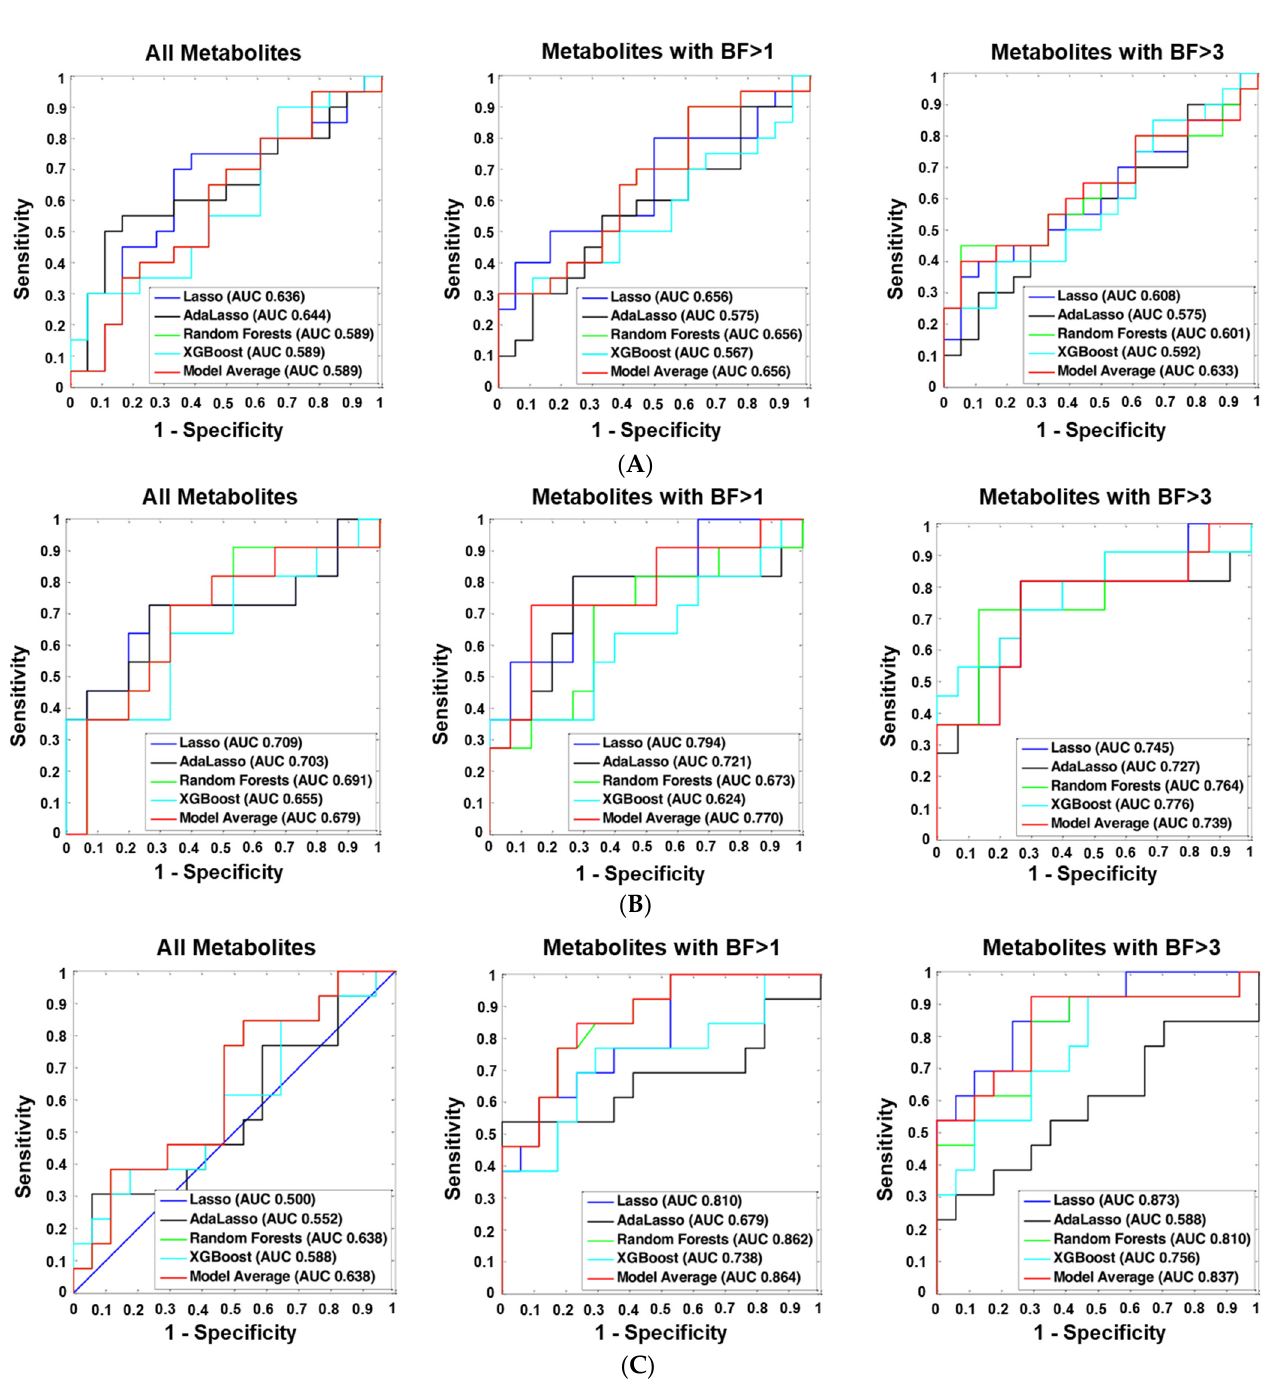
Figure 3. ME/CFS predictive modeling. ME/CFS: myalgic encephalomyelitis/chronic fatigue syndrome; sr-IBS: self-reported physician diagnosed irritable bowel syndrome; BF: BayesFactor; AUC: area under the receiver operating characteristic curve. To differentiate ME/CFS cases from healthy controls, we employed five machine learning algorithms: least absolute shrinkage and selection operator (Lasso), adaptive Lasso (AdaLasso), Random Forests (RF), XGBoost, and Bayesian Model Averaging (Model average). For each algorithm, three sets of predictors were considered: (1) all metabolites, (2) metabolites with BayesFactor > 1, and (3) metabolites with BayesFactor > 3. The predictive models were first trained in the 80% randomly selected training set using 10-fold cross-validation, and the remaining 20% of the study population was used as the independent test set to validate model performance. ( A ) Overall population. ( B ) Women only. ( C ) No GI complaints.